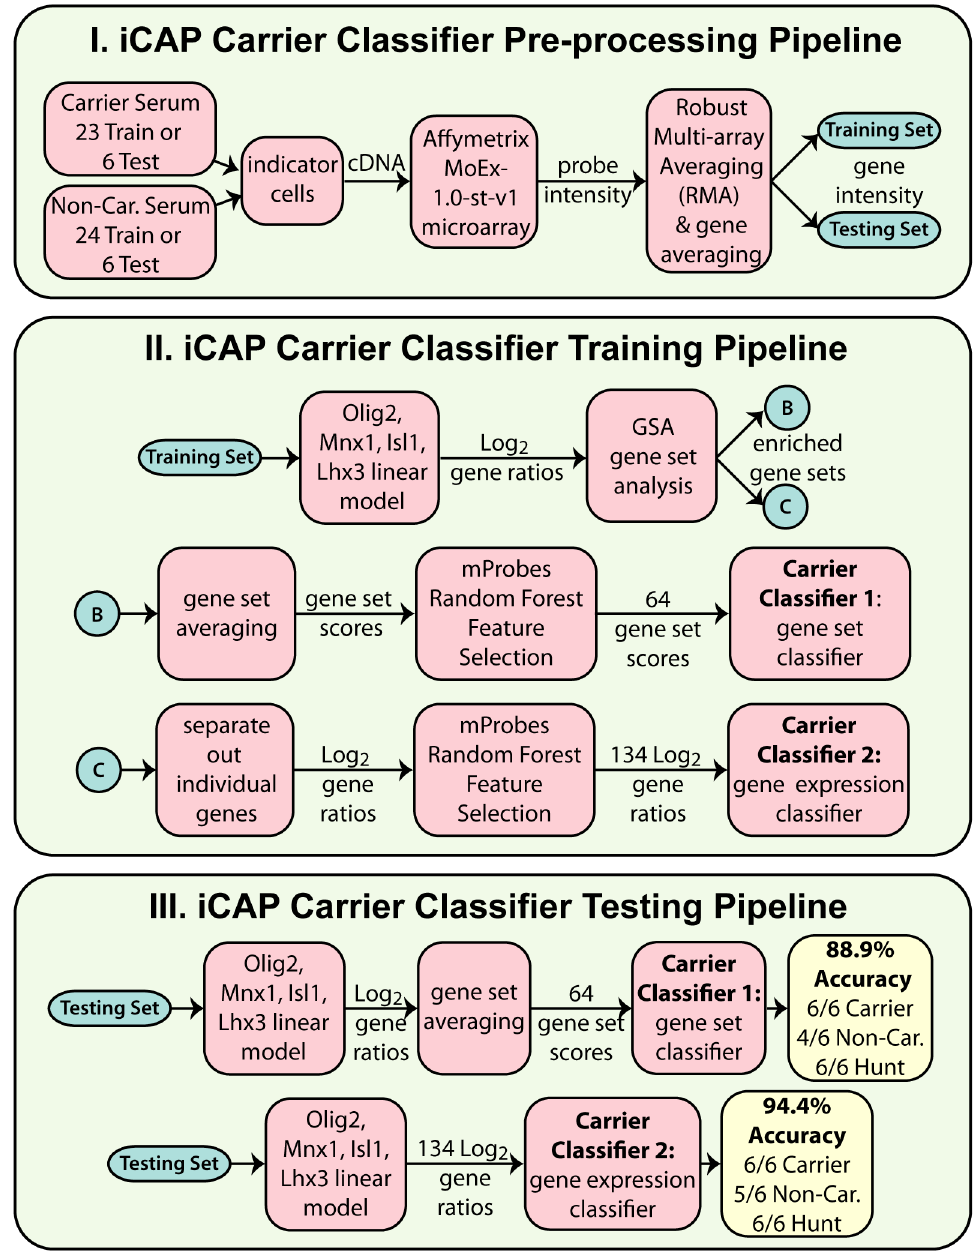
Fig 2. Classifier pipelines. I. 47 trainingsamples or 12 test samples passed through the pre-processing pipeline,which resultedin normalized gene intensity scores. II. The classifiers were trained. 12 non-carrier (non- car.) samples in the 47 trainingexampleswere used to construct a linear model of gene expressionbased on control genes, which was used to convert all gene intensities into log2 gene expressionratios. These ratios were used to identify differentially expressedgene sets and ultimatelyselect 64 gene sets or 134 genes that could differentiate between non-carrier and pre-symptomatic carrier mice using SVMs. III. The classifiers were tested. Gene intensities from 12 pre-processed but de-identified exampleswere convertedto expressionratios using the linear model trained in II, and data sets composed of the 64 gene sets or 134 genes identified in II were extracted. The de-identified examplesdescribedby these data sets were classifiedas carrier or non-carrier using the SVMs trained in II. The pipelinefor Classifier3 was identicalto that of Classifier 1 except that a different GSA score thresholdwas used (|GSA| (cid:21) 1 instead of GSA (cid:20) -1), resulting in selection of 106 gene sets insteadof 64. For classifier testing with Huntington’s samples, classifiers were trained with all 59 normal and diseasesamples (not shown) and tested against 6 Huntington’s samples. For each classifier configuration,the